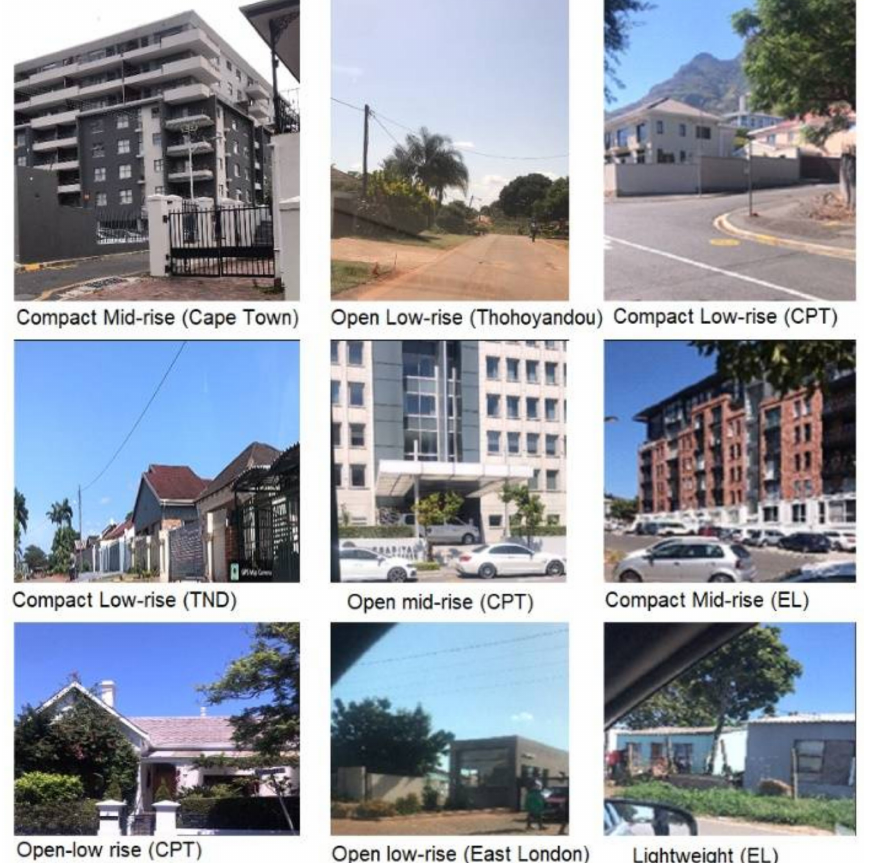
Figure 2. Some of the sampled locations across Cape Town, East London and